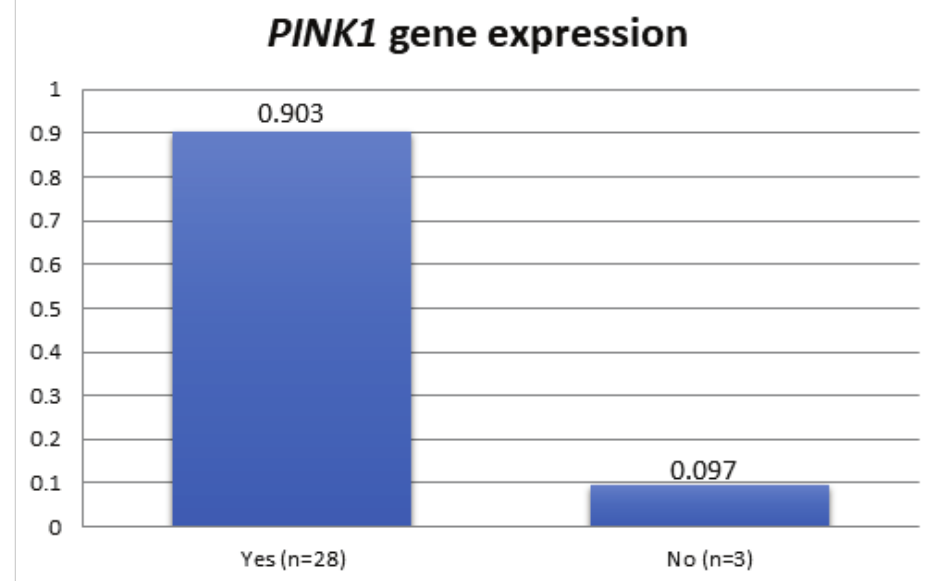
The association between PINK1 gene and age at onset: 100% of the patients in age group less than 20, 81.8% in age group 20–40 yr, and 91.7% of the patients in age group 40–50 ys expressed PINK1 gene. But the difference was statistically insignificant ( P = 0.408; Figure